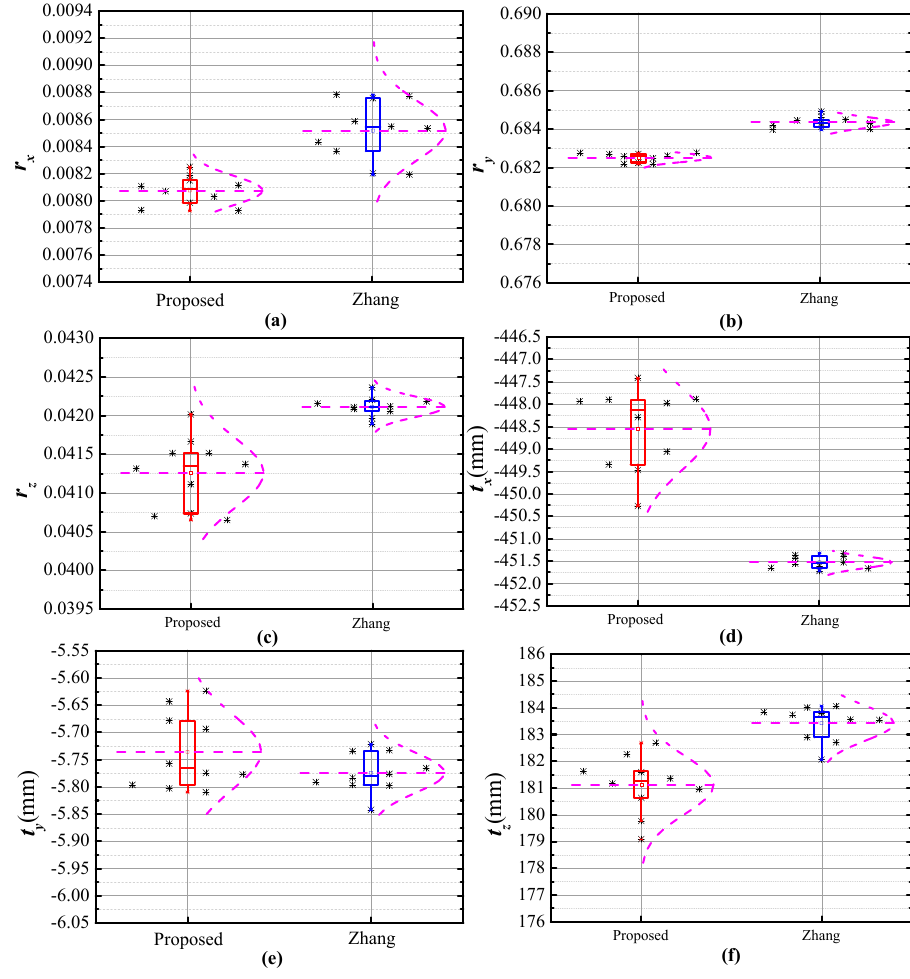
Figure 15. Repeatability of calibration results via two methods. ( a ) Repeatability of r x via two methods; ( b ) Repeatability of r y via two methods; ( c ) Repeatability of r z via two methods; ( d ) Repeatability of t x